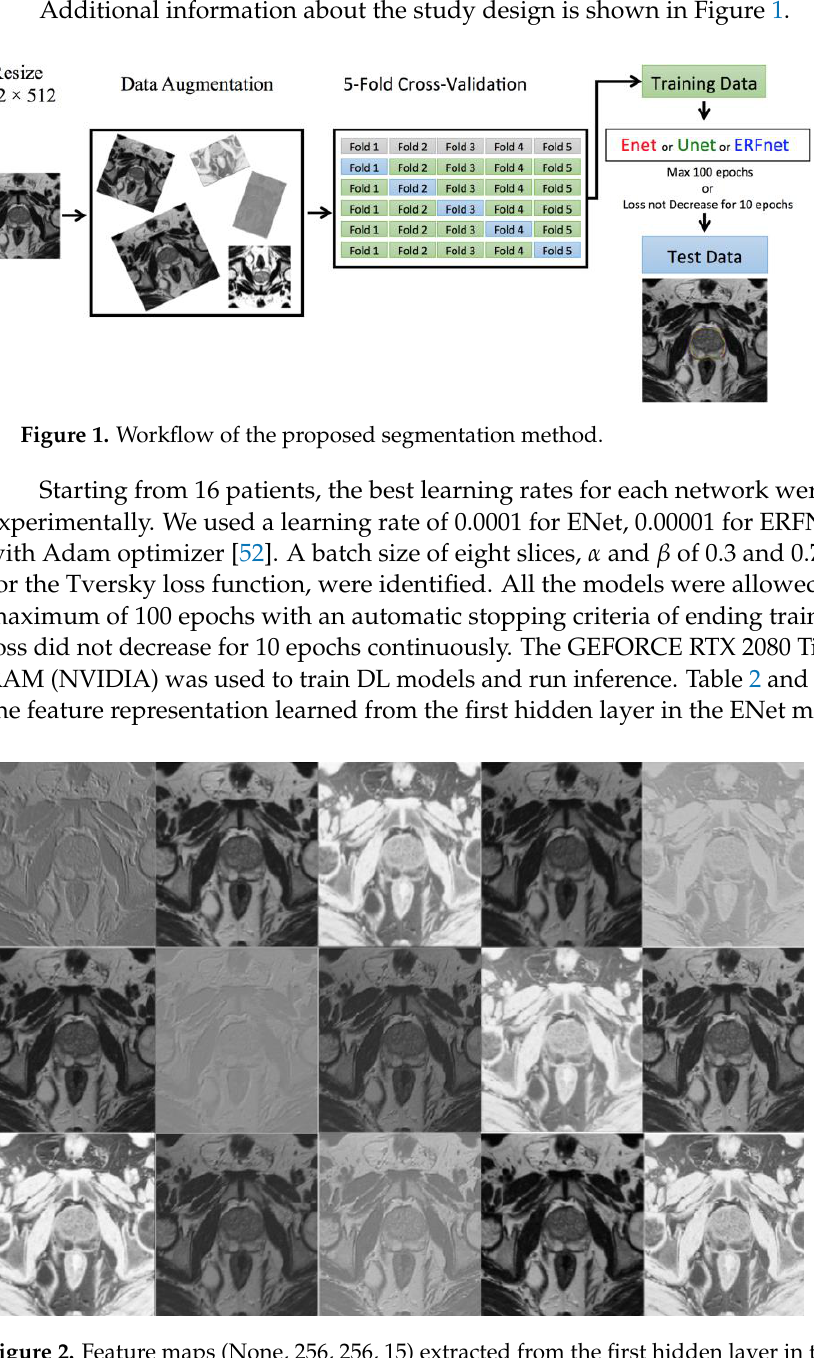
Figure 2. Feature maps (None, 256, 256, 15) extracted from the first hidden layer in the ENet Model for Patient #7 slice #20.